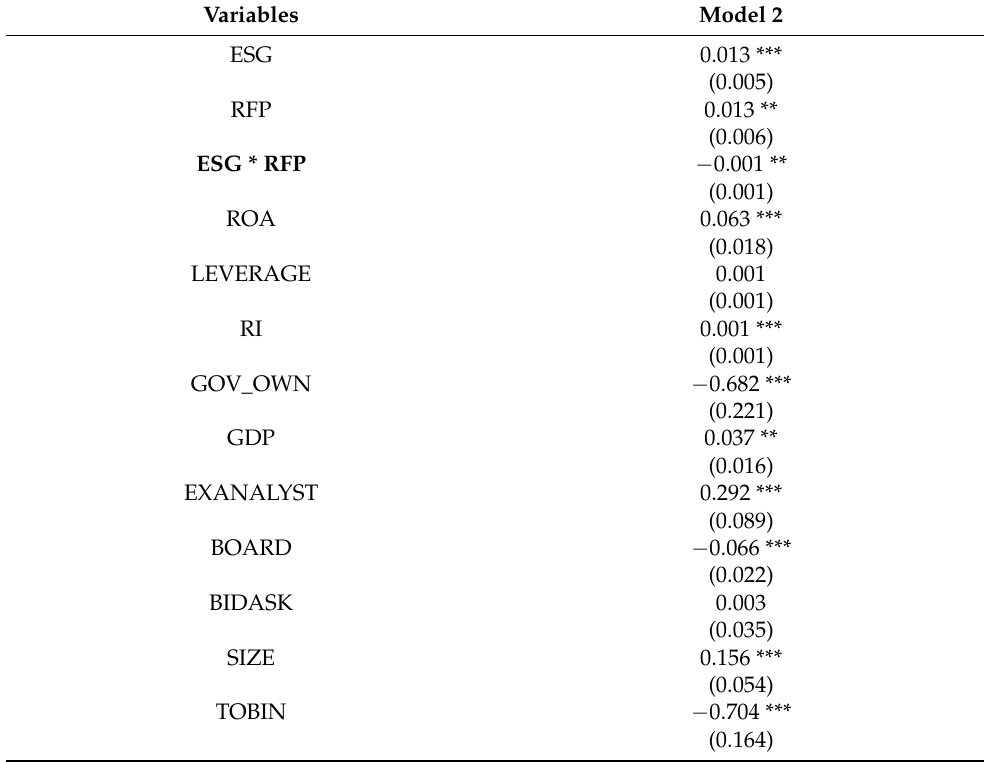
Table 7. The moderating effect of royal family between ESG and